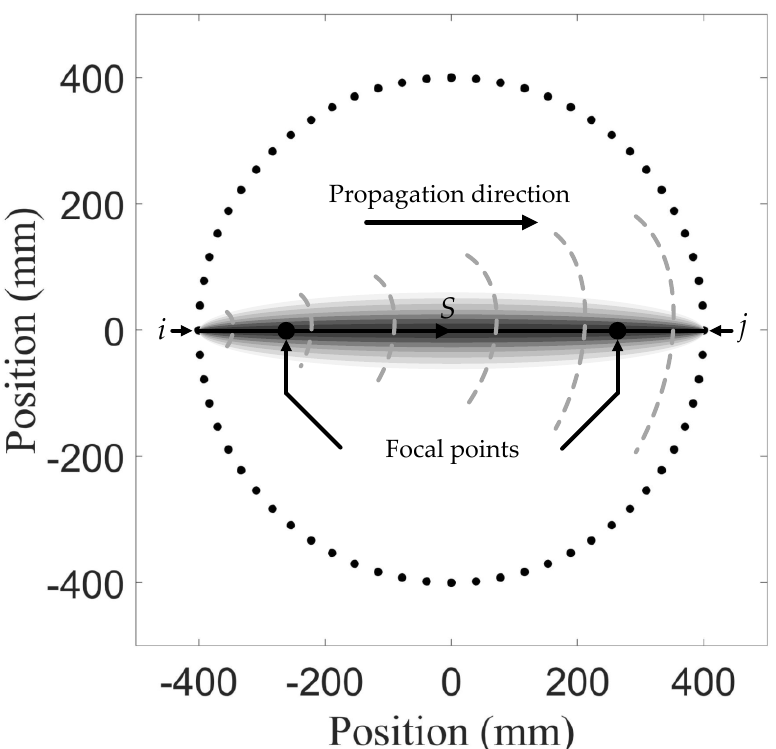
Figure 7. The ellipse of the elliptic algorithm, whose vertices of the ellipse are respectively regarded as the actuating signal sensor and the receiving signal sensor. The intensity on the line connecting the two vertices is the highest, indicating that the probability of degradation is the greatest. The probability is divided into 20 levels and decreases from the middle to both sides, and the probability of the edge and the periphery of the ellipse is